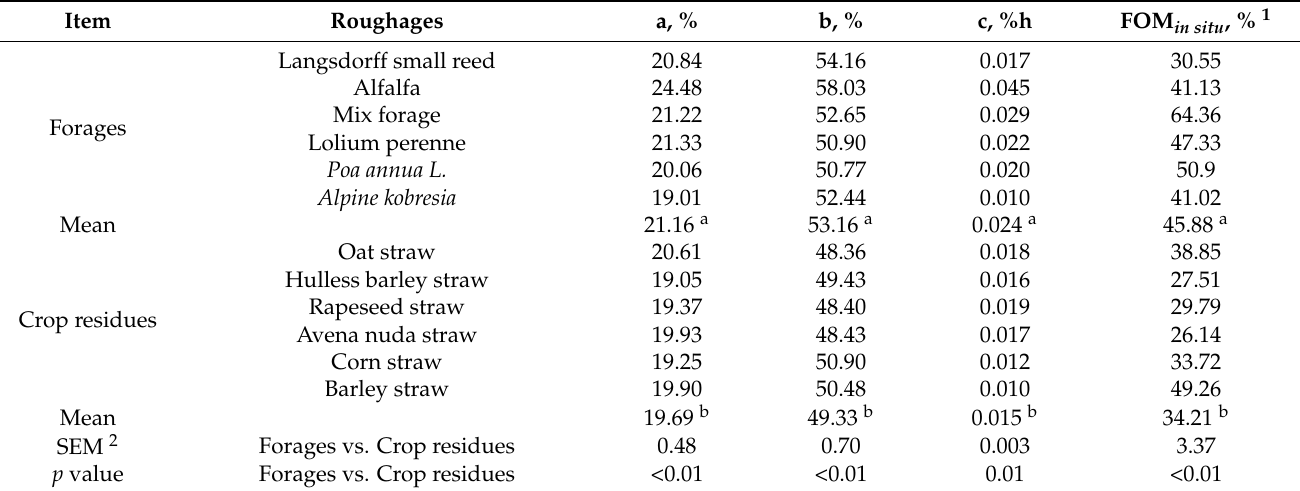
Table 2. In Situ organic matter degradation characteristics of